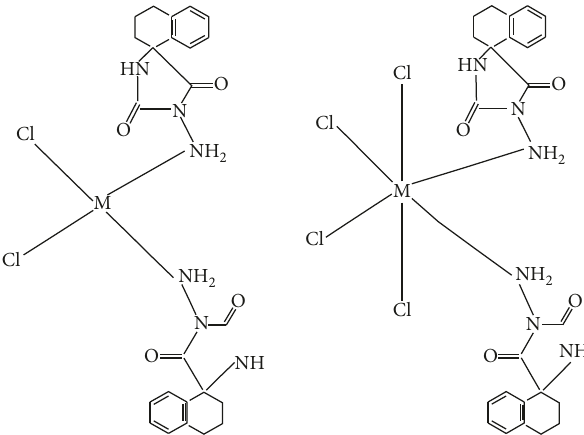
5 H 4 N-2- Figure 9: Four Pt(II), Pt(IV), Pd(II), and Pd(IV) coordination compounds using 3-amino- α -tetralonespiro-5 ′ -hydantoin as car- rier ligand (where M � Pd or